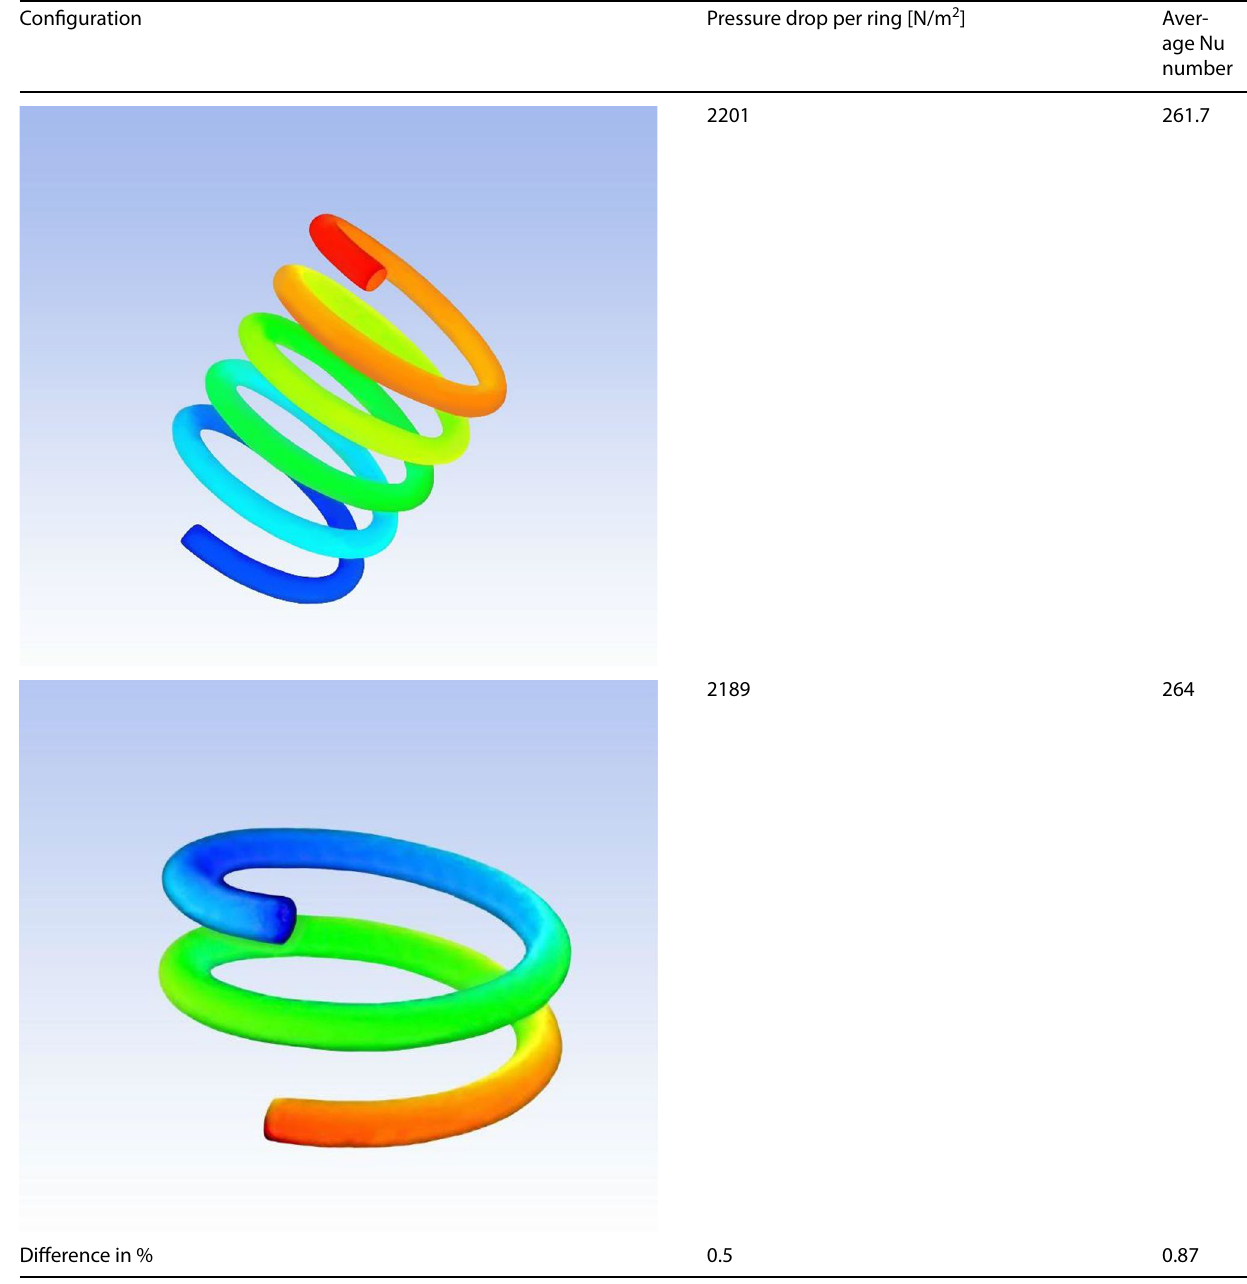
Table 2 Comparing the difference of Pressure drop and local nusselt between two rings and five rings coils